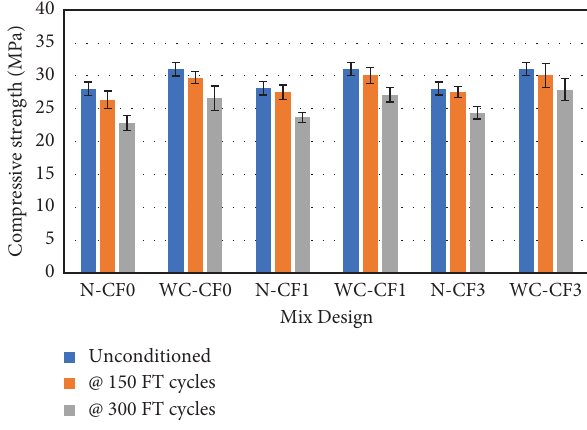
Figure 3: Results of 28-day compressive strength.